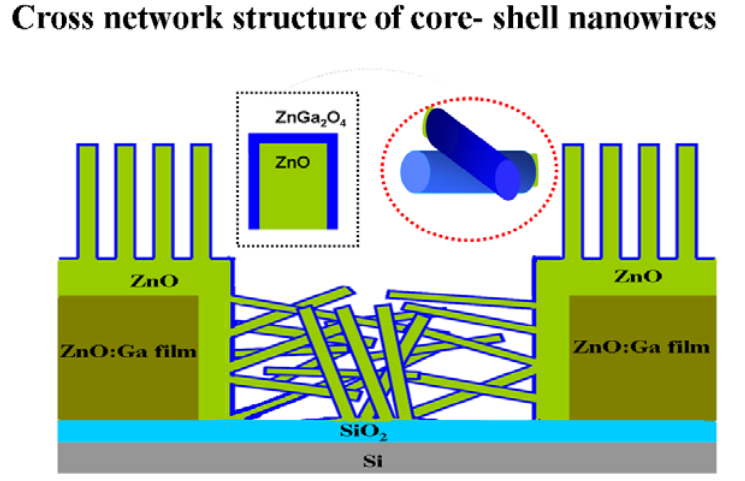
Figure 2. A schematic diagram of cross network structure as sensing layers of the O /ZnO core-shell nanowires based ZnGa 2 4